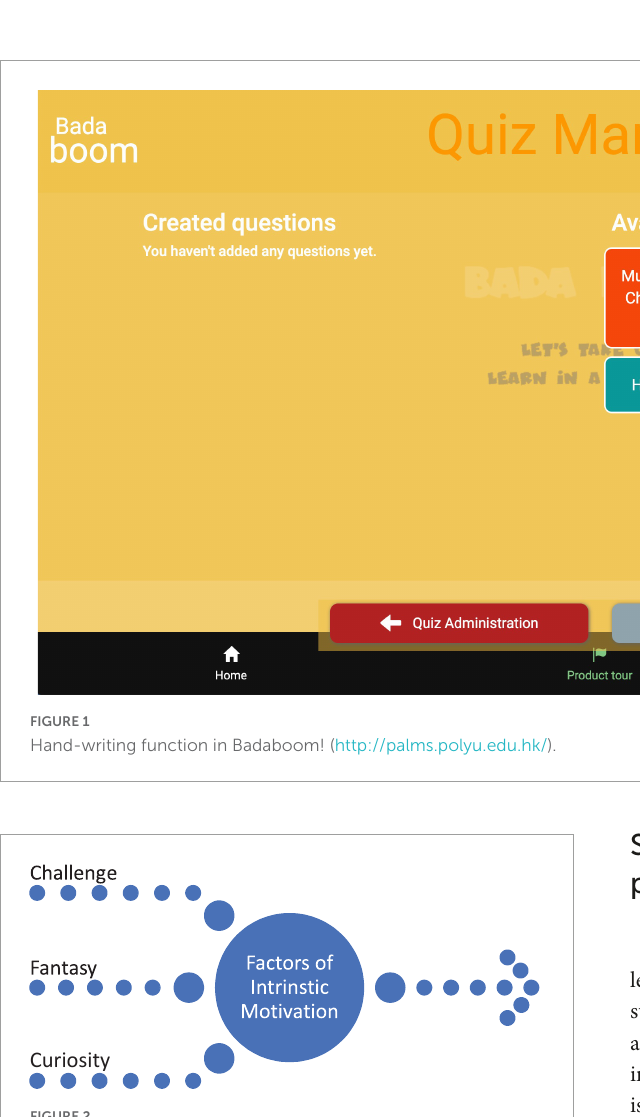
FIGURE2 Modified conceptual map of Malone’s Intrinsic Motivation Model